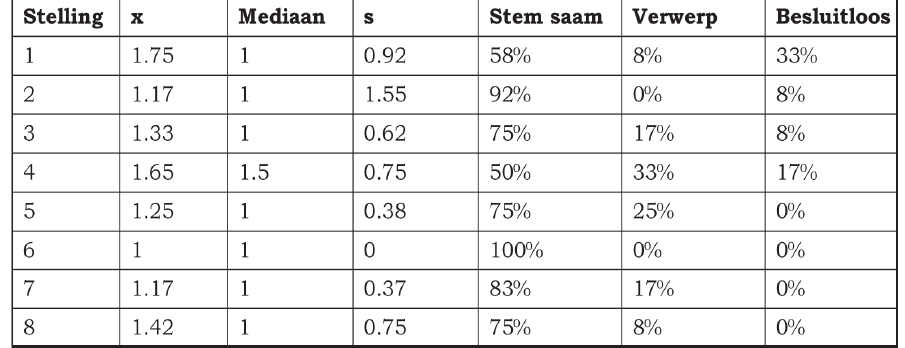
Uit Tabel 2 blyk dit dat die rekeningkundige gemiddeldes van